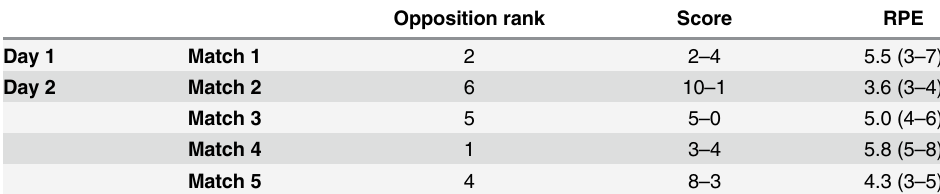
Table 1. Opposition ranking and score for matches during the